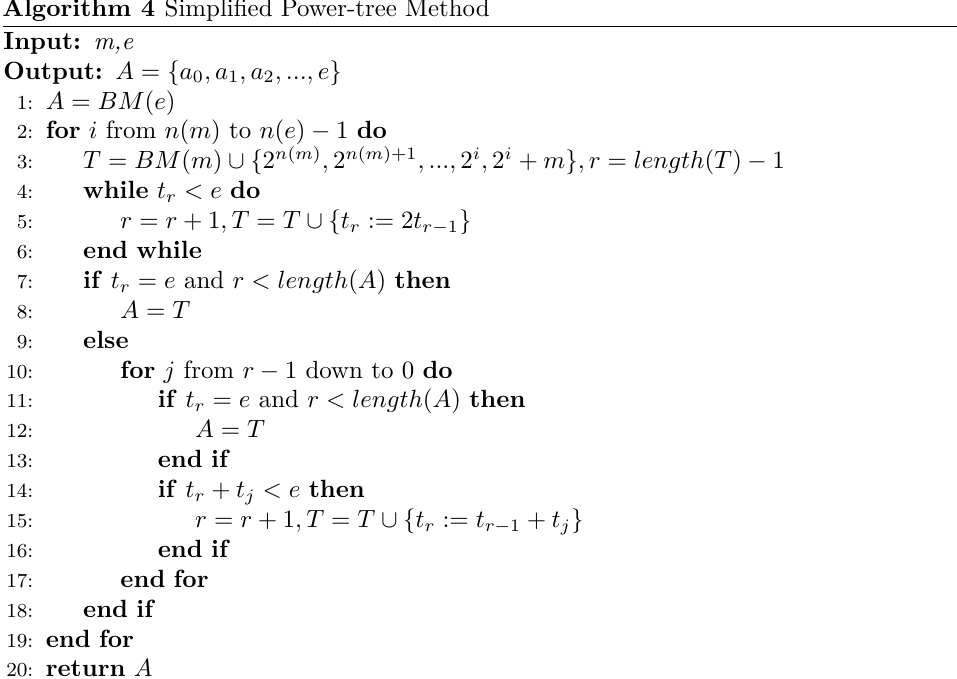
Algorithm 4 Simplified Power-tree Method